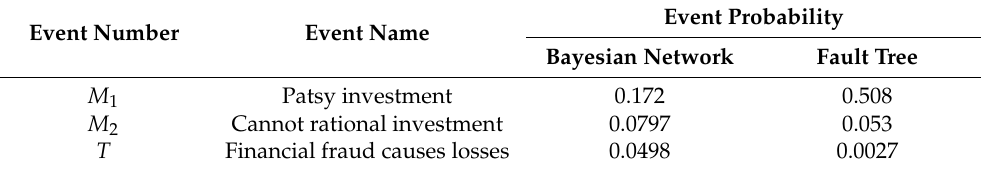
Table 3. Event name and